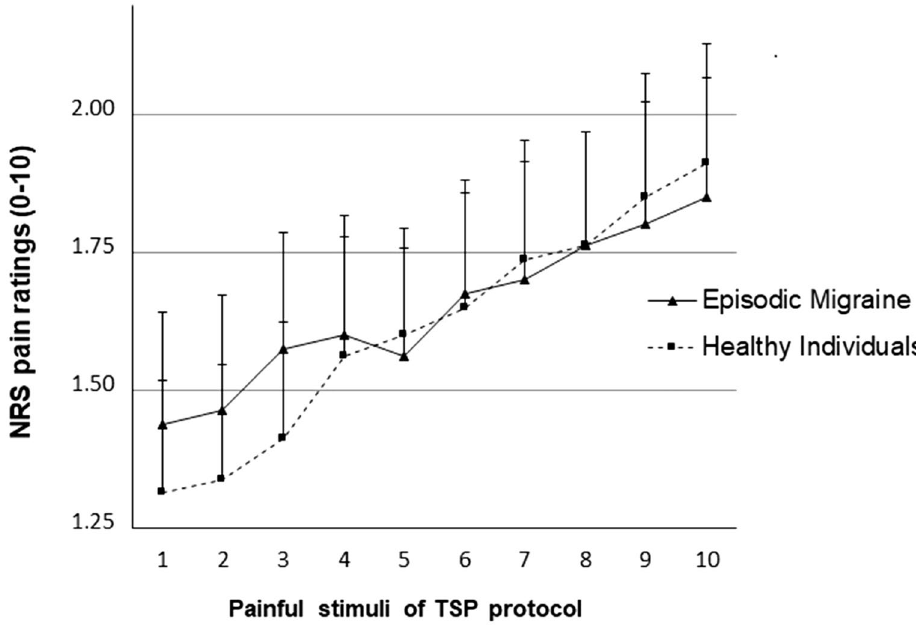
Figure 2. Mean (± SE) NRS pain ratings (0–10) over repeated stimuli as a function of group across the 10 painful stimuli of the TSP protocol.